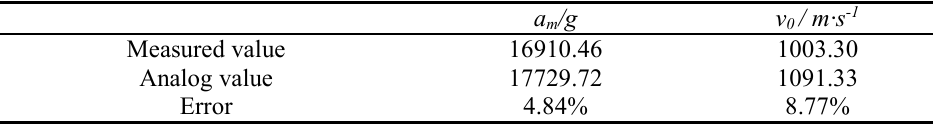
Table 1. Field test results and simulation